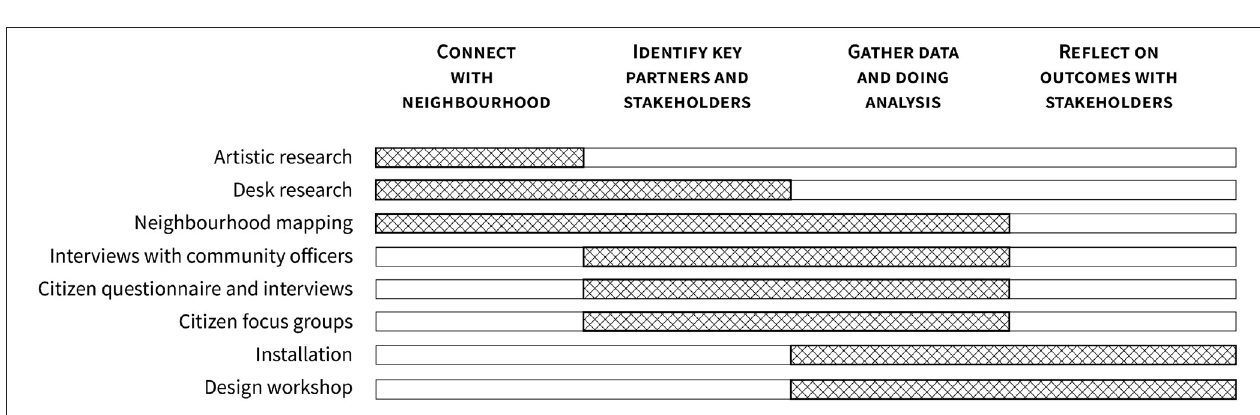
FIGURE 3 | An overview of how the applied methods in Bouwlust fit within the four activities from the proposed framework.